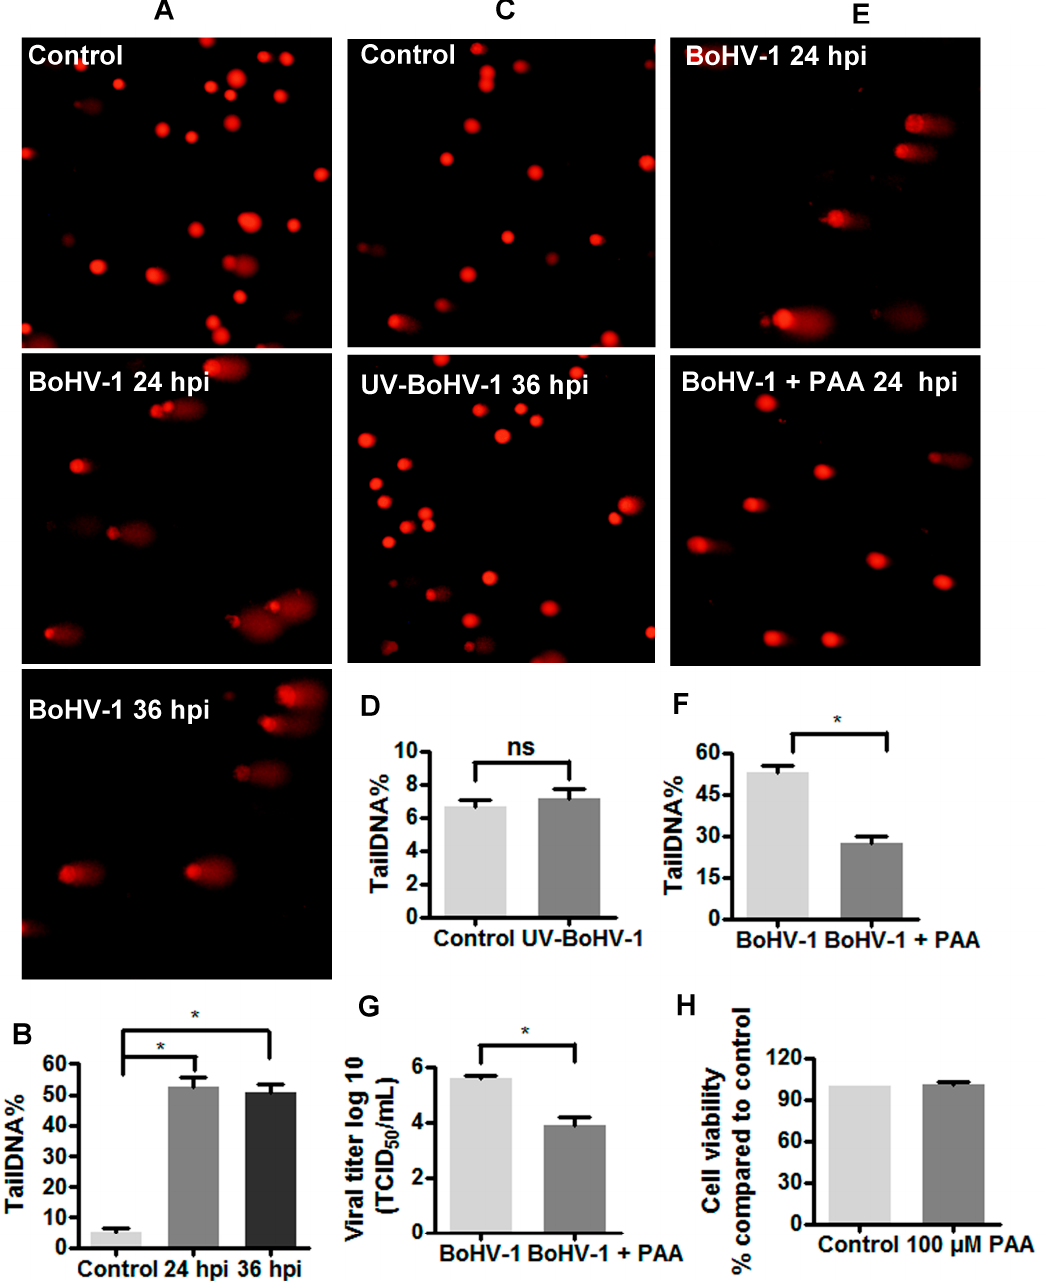
Figure 1. The detection of DNA damage in BoHV-1 infected MDBK cells. ( A ) MDBK cells were infected with BoHV-1 (MOI = 0.1), and at indicated time points the cell cultures were collected to measure DNA damage in individual cells with comet assay. The images were acquired under a fluorescence microscope. Results were of three independent experiments (Magnification × 200). ( B ) Three hundred cells randomly selected from each sample were used for the calculation of tailDNA% by software CASP. Values represented three independent experiments. *, significant differences ( P < 0.05) in tailDNA%, as determined by a Student t test. ( C ) MDBK cells were infected with UV-inactivated BoHV-1 (MOI = 0.1). After infection for 36 h, the cells were collected and subjected to